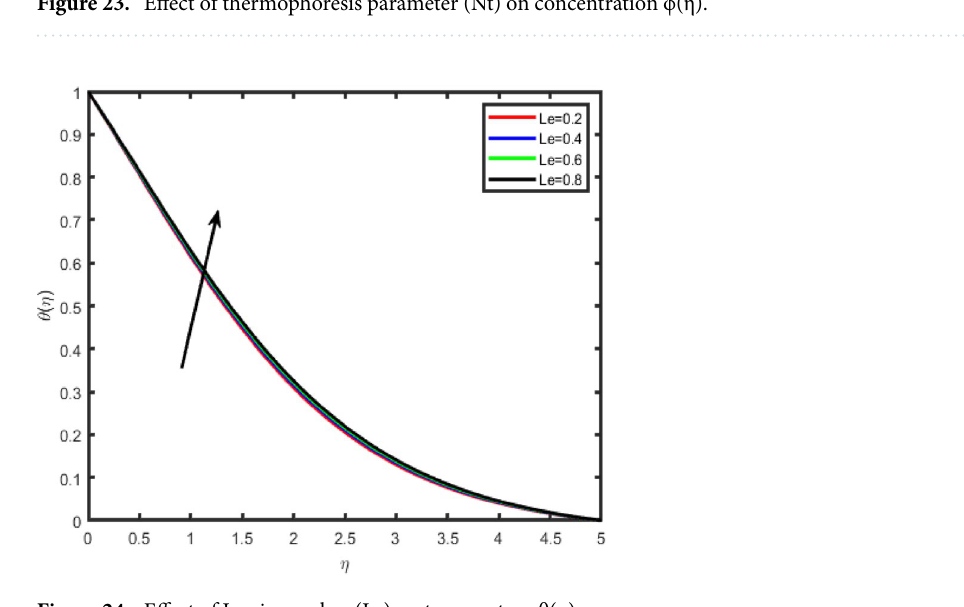
Figure 24. Effect of Lewis number (Le) on temperature